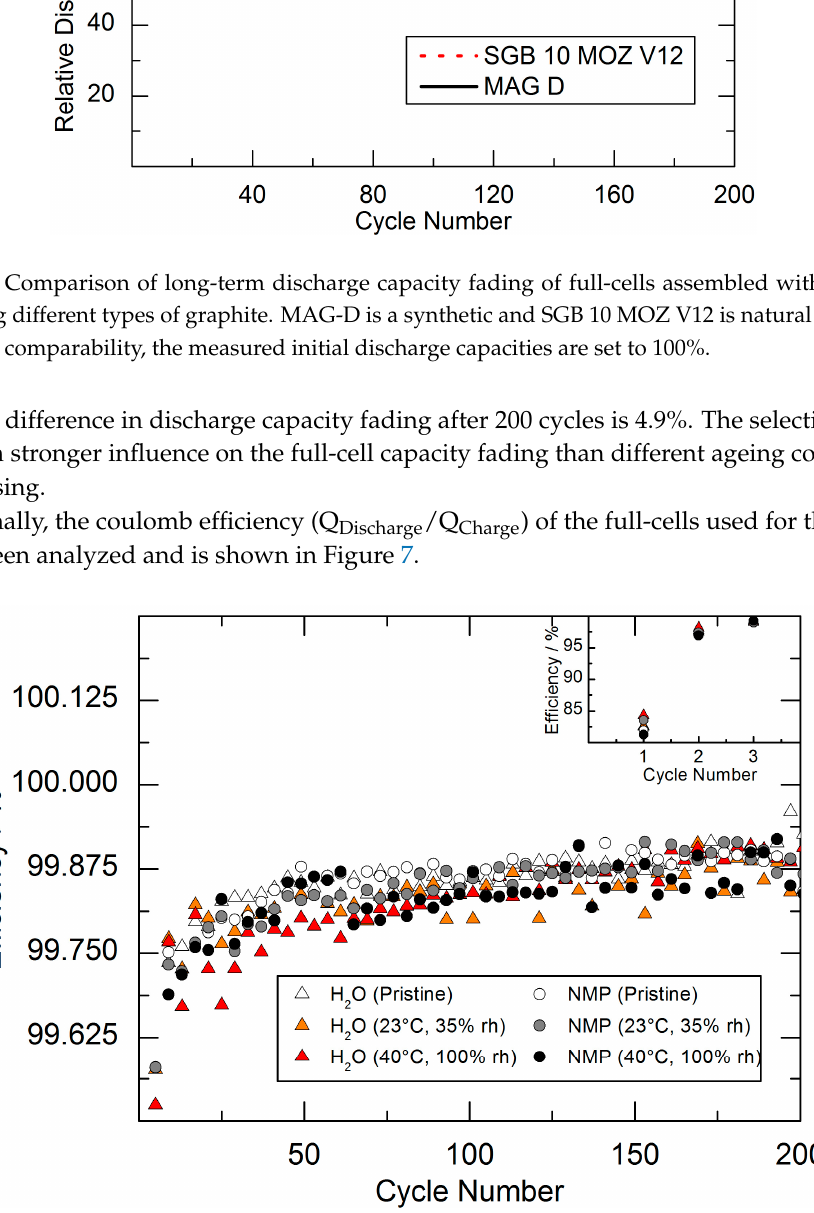
Figure 7. Coulomb efficiency of full-cells used for the long-term cycling at a 1 C-rate. Inset shows the coulomb efficiency observed during the first 3 cycles and illustrates the correlation between initial capacity loss caused by the formation of the SEI layer and reduced coulomb efficiency.